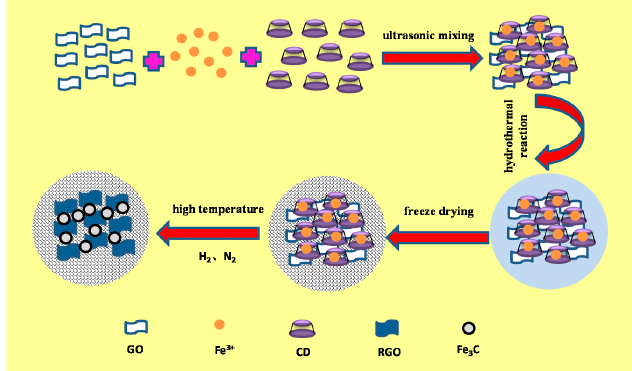
Figure 1. The formation mechanism of self-assembled nano-Fe 3 C@RGO aerogel.